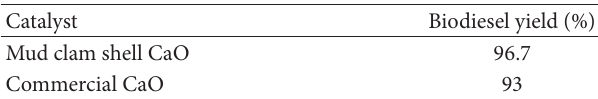
Table 3: Biodiesel yield of calcium oxide catalyzed transesterifica- tion using optimum reaction